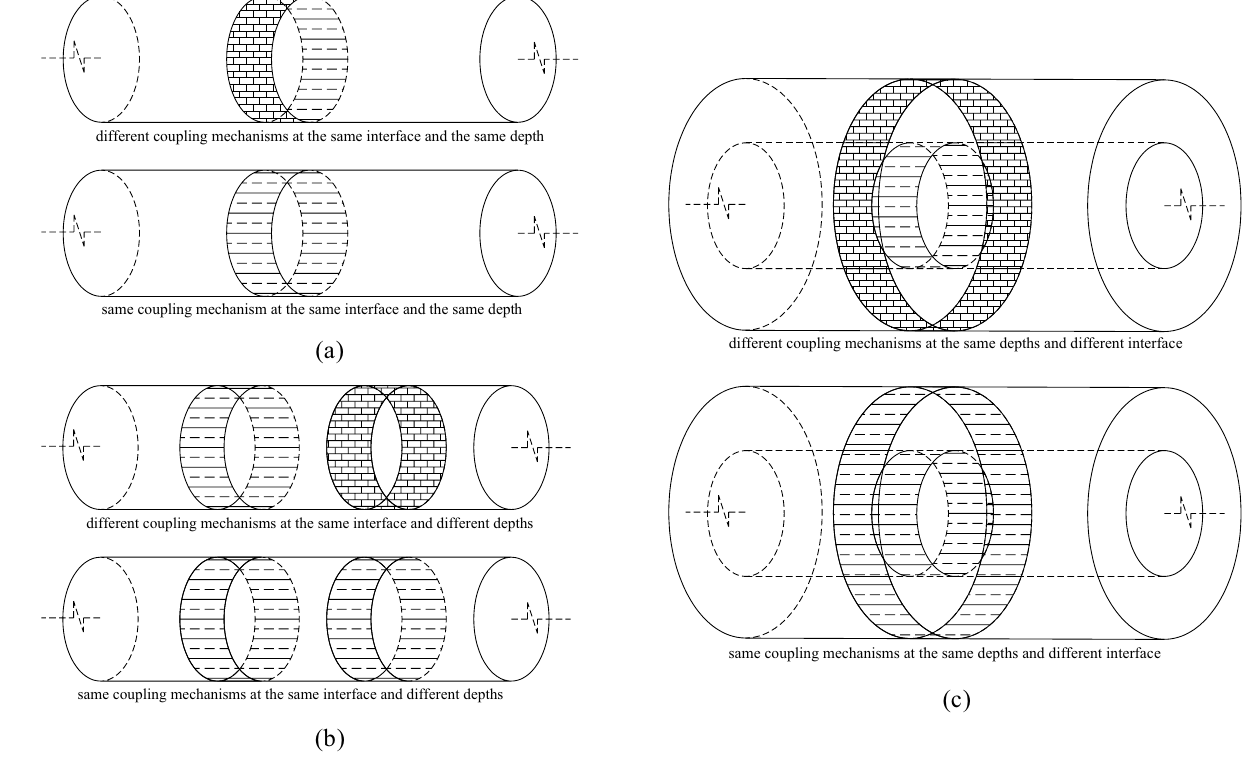
Figure 4. Interface coupling mechanism combination analysis